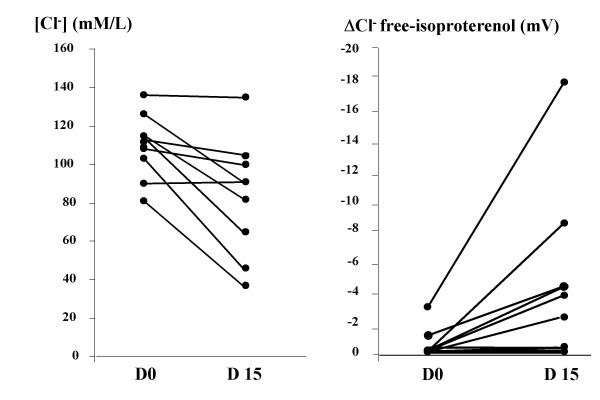
Sweat chloride concentration and ΔCl- free-isoproterenol before and after gentamicin in Y122X patients (●). Previously published representative data of healthy controls (○) are shown [27].